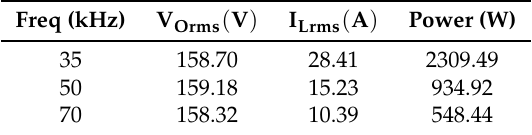
Figure 10. Experimental waveforms captured through the oscilloscope: Channel 1 (blue), v O ; Channel 4 (red), i L , for switching frequencies of ( a ) 35 kHz, ( b ) 50 kHz, and ( c ) 70 kHz. Table 4. Voltage, current and power measured by the oscilloscope for different